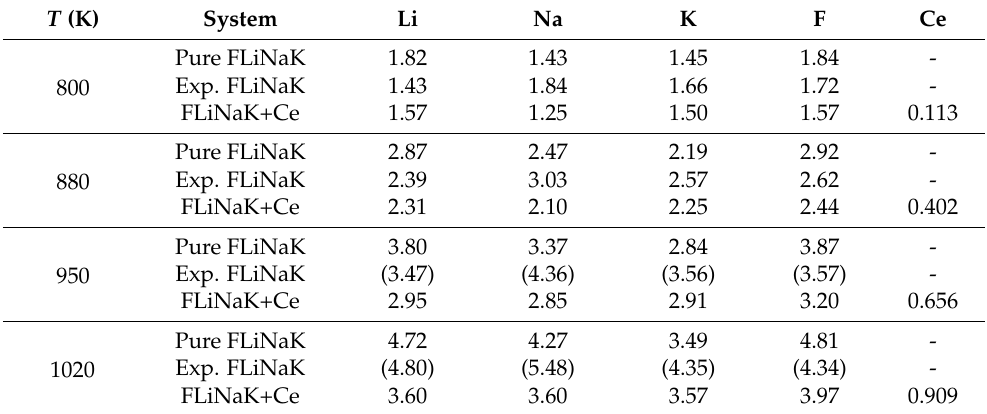
Table 2. Self-diffusion coefficients of ions (in units of 10 − 5 cm 2 /s) in FLiNaK and mixture FLiNaK+CeF 3 calculated by the Arrhenius relation from data of MD calculation and experiment [28] *.